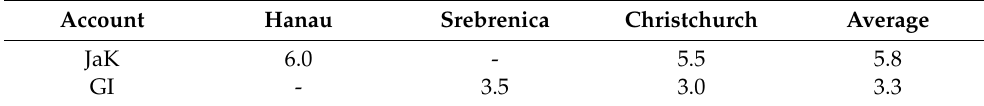
Table 3. Persuasive potential of